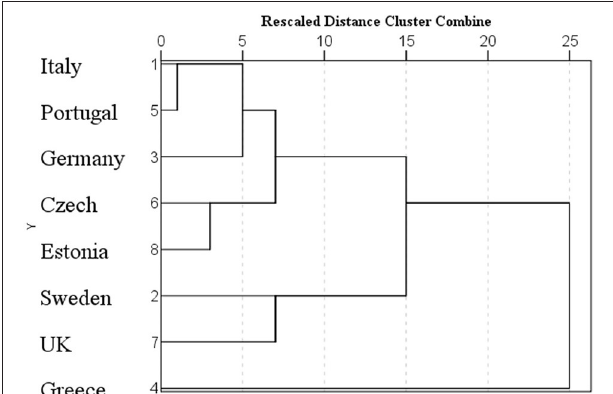
FIGURE 5 | Country cluster dendrogram based on between group average